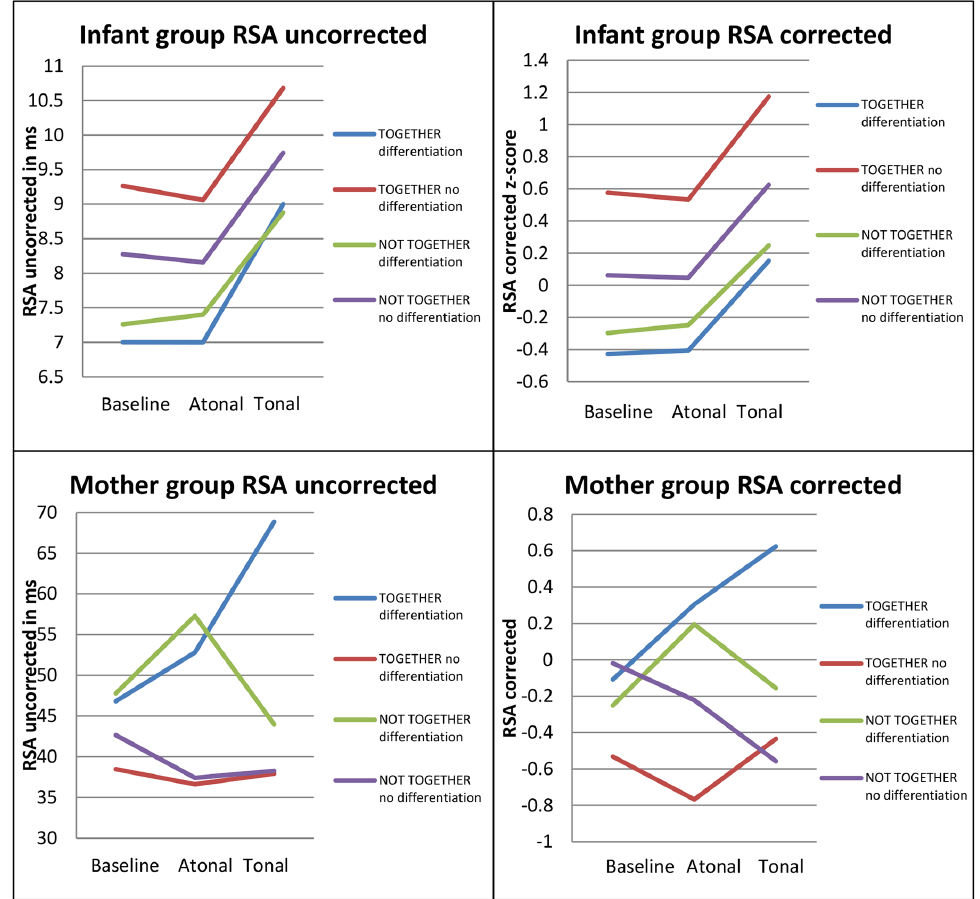
Figure 4. Overview of RSA-responses before and after correction for respiratory and motor confounds in mother group and infant group.